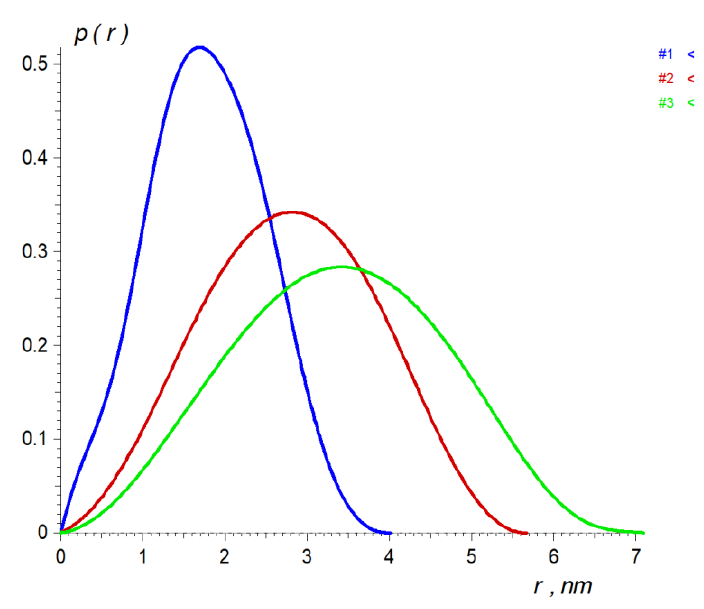
Figure 7. Distance distribution p(r) functions computed from the experimental SAXS data from the 4th (blue), 6th (red) and 7th (green) generations of carbosilane-siloxane dendrimers. The scattering from the MD models was evaluated by the program CRYSOL